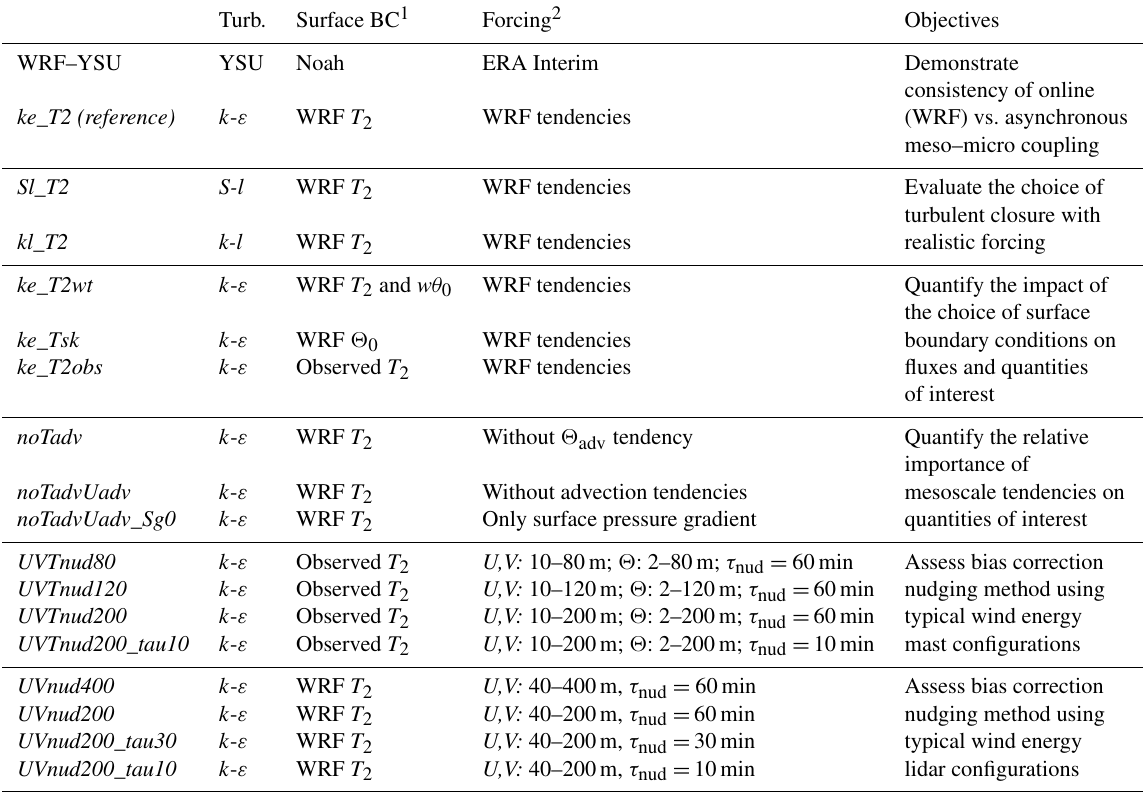
Table 1. List of simulations and objectives for the sensitivity analysis of single-column